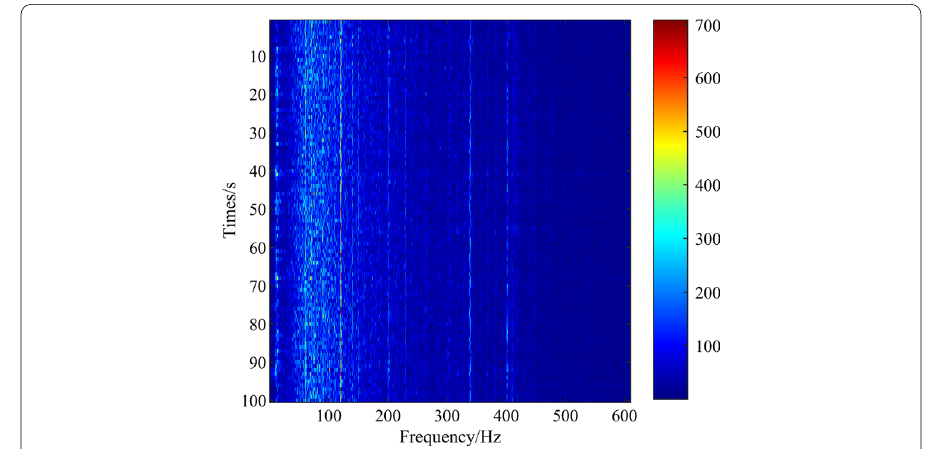
Fig. 16 Original lofargram of first set of